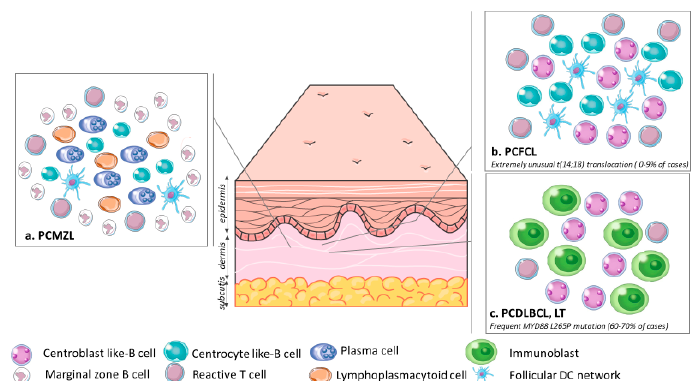
Figure 2. Organization of the tumor cells and microenvironment in ( a ). PCMZL: Infiltrate made of small centrocyte-like B-cells, lymphoplasmacytoid cells, plasma cells and reactive T cells admixed with a FDC network surrounded by marginal zone B cells; ( b ). PCFCL: Infiltrate made of centrocytes and centroblasts often with a FDC network and scattered reactive T cells; ( c ). PCDLBCL, LT: A monomorphic population of large atypical cells ressembling centroblasts and immunoblasts. The t (14; 18) translocation is extremely rare in PCFCL, unlike in primary nodal follicular lymphoma. The PCDLBCL, LT is characterized by frequent MYD88 L265P mutations, which helps discriminate PCDLBCL, LT from PCFCL with large cells, in which the MYD88 L265P mutation is absent. Abbreviations: PCMZL, primary cutaneous marginal zone lymphoma; PCFCL, primary cutaneous follicle center lymphoma; PCDLBCL, LT, primary cutaneous di ff use large B-cell lymphoma, leg type; DC, dendritic